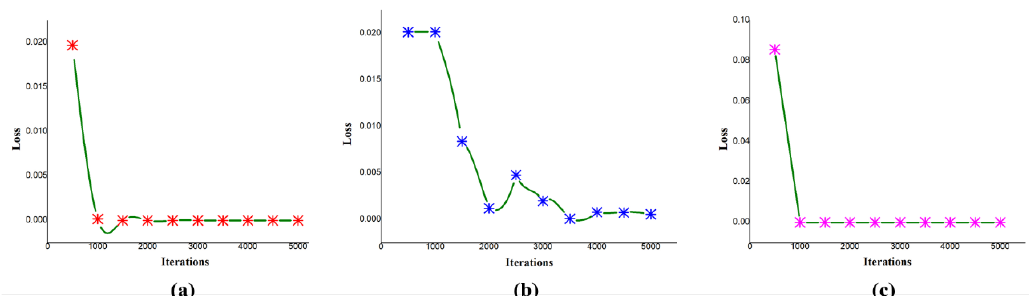
Figure 7. ( a ) Variation of loss with different iterations on hockey fight [7] dataset with a learning rate of 0.001; at the horizontal position, the initial iteration from zero grows towards the final